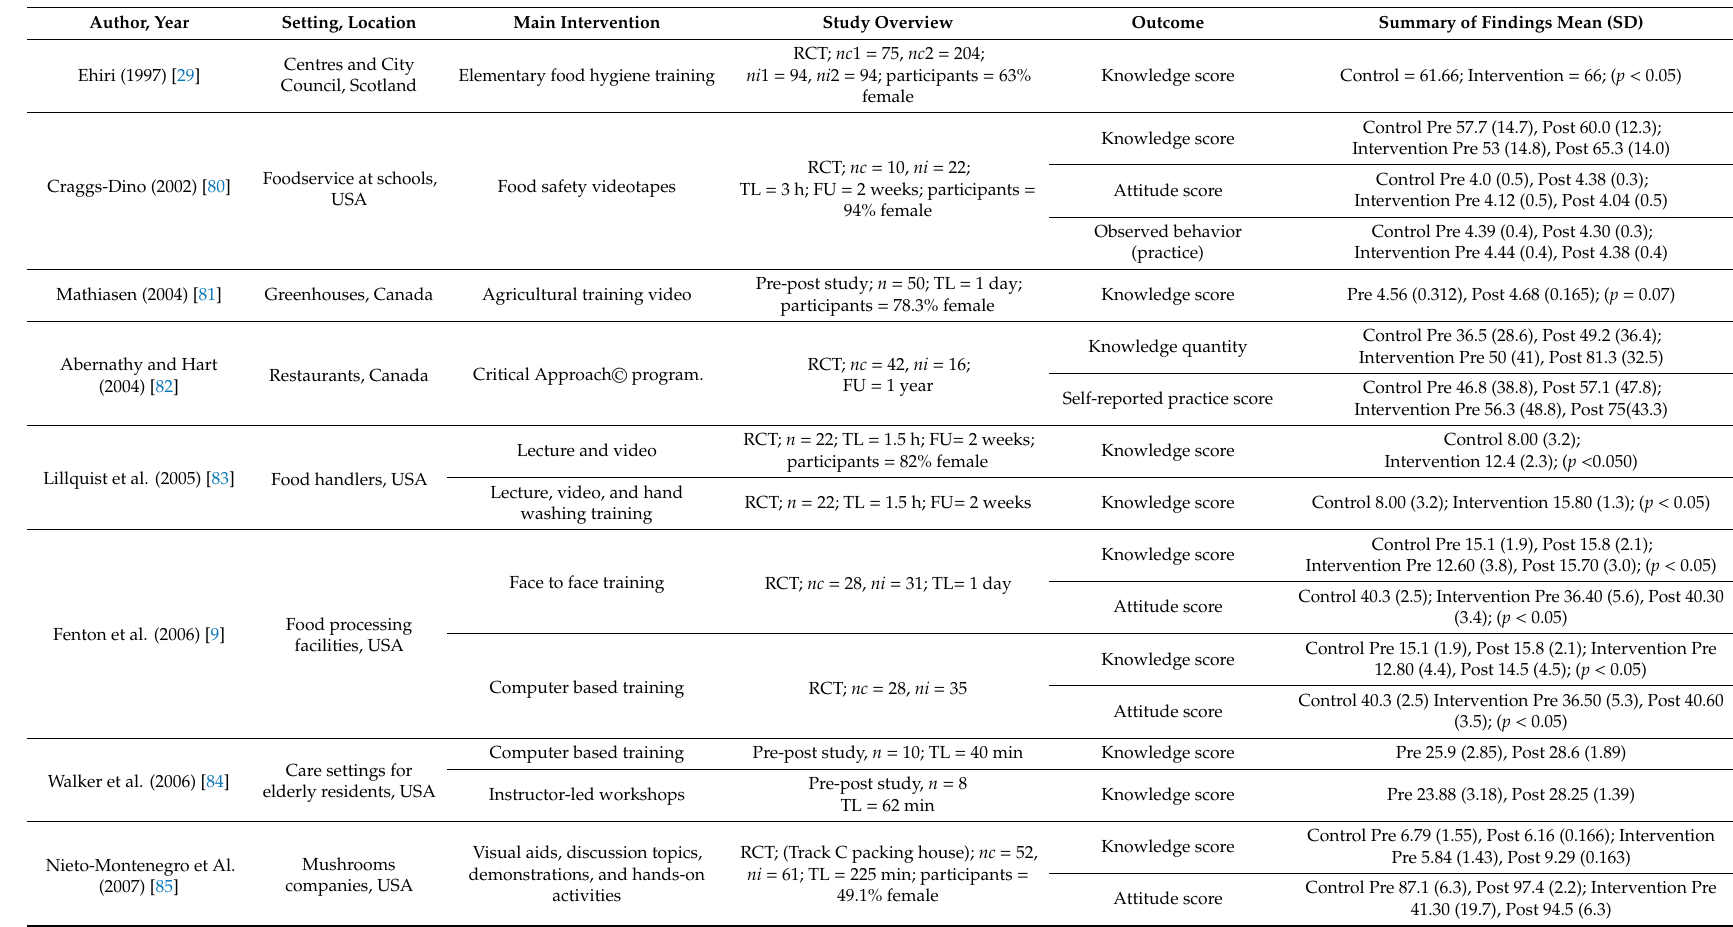
Table 1. Summary of